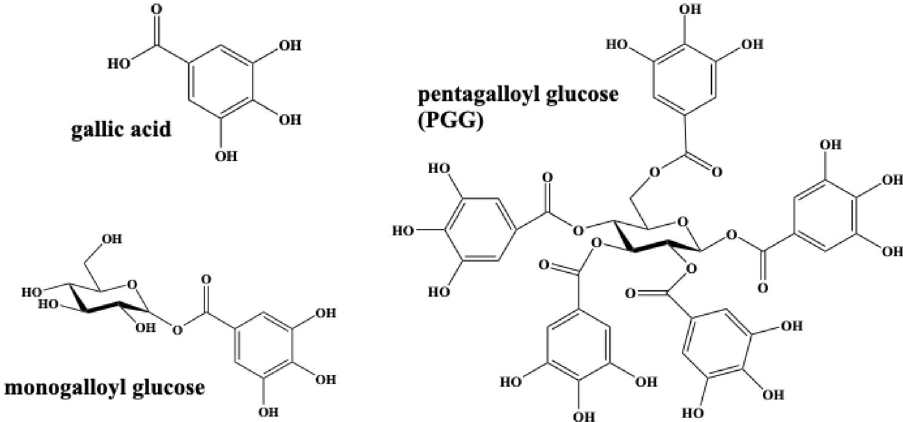
Figure 1. Molecular structures of gallic acid, monogalloyl glucose and pentagalloyl glucose